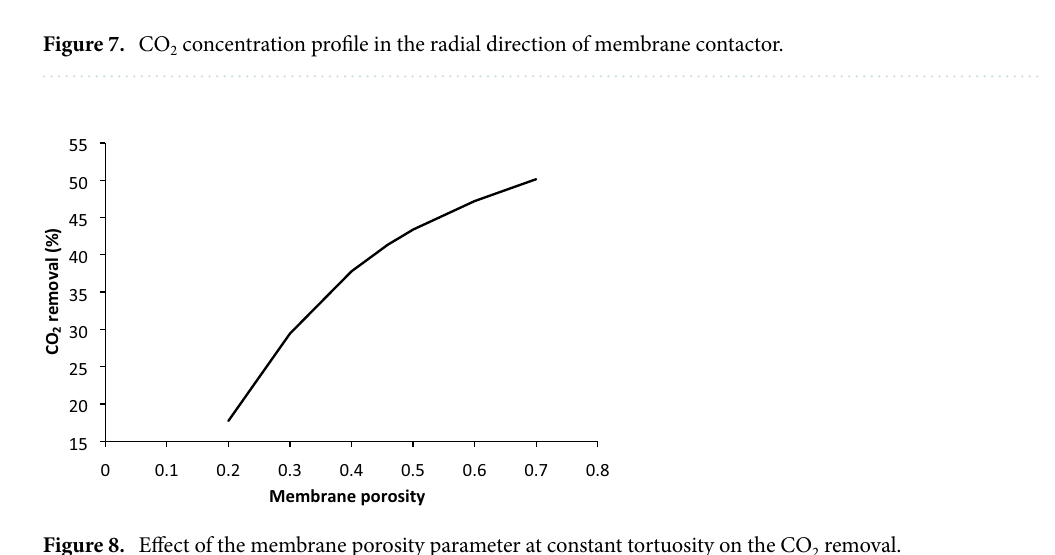
Figure 8. Effect of the membrane porosity parameter at constant tortuosity on the CO 2